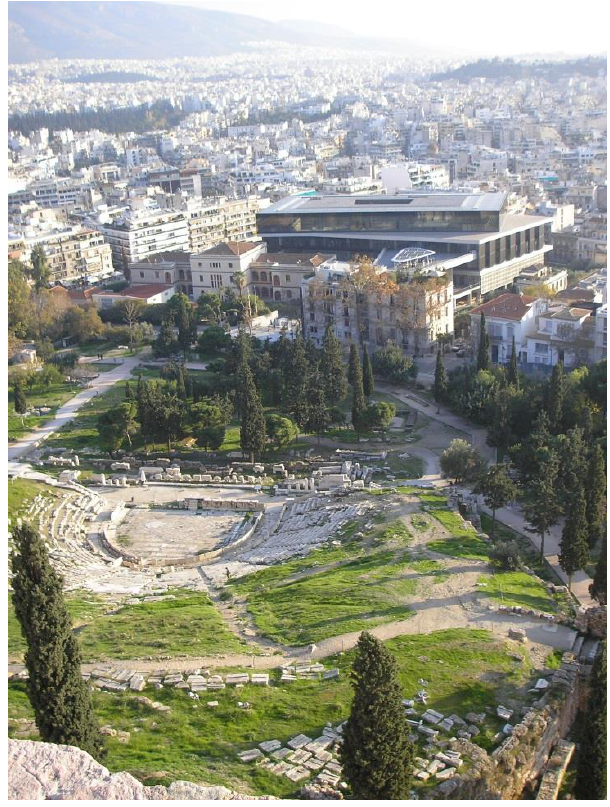
Figure 2. The New Acropolis Museum and south-eastern Athens as seen from the summit of the Acropolis. The southern slopes of the Acropolis, and the Theatre of Dionysus, lie in the foreground. Photograph: J. Beresford.